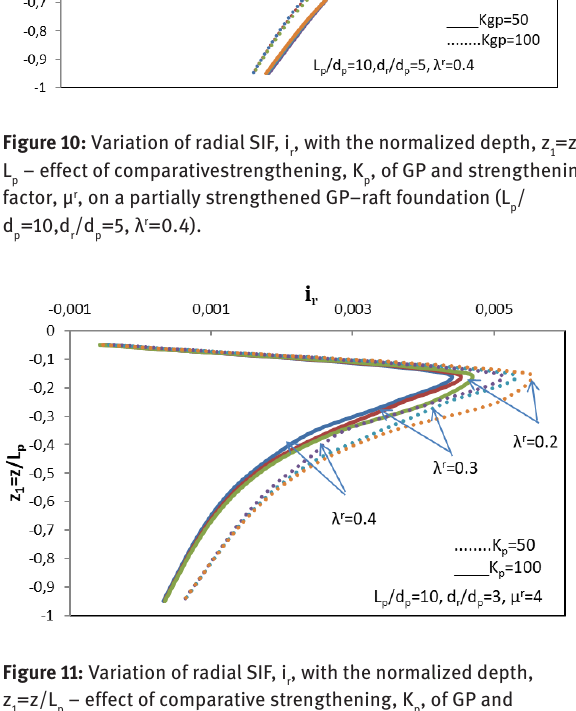
Figure 13: Variation of normalized shear stresses, τ*= τ/(F/πd with radial compatibility of the normalized depth, z of stiffness factor, μ, and comparative strengthening, K partially strengthened GP–raft foundation (L